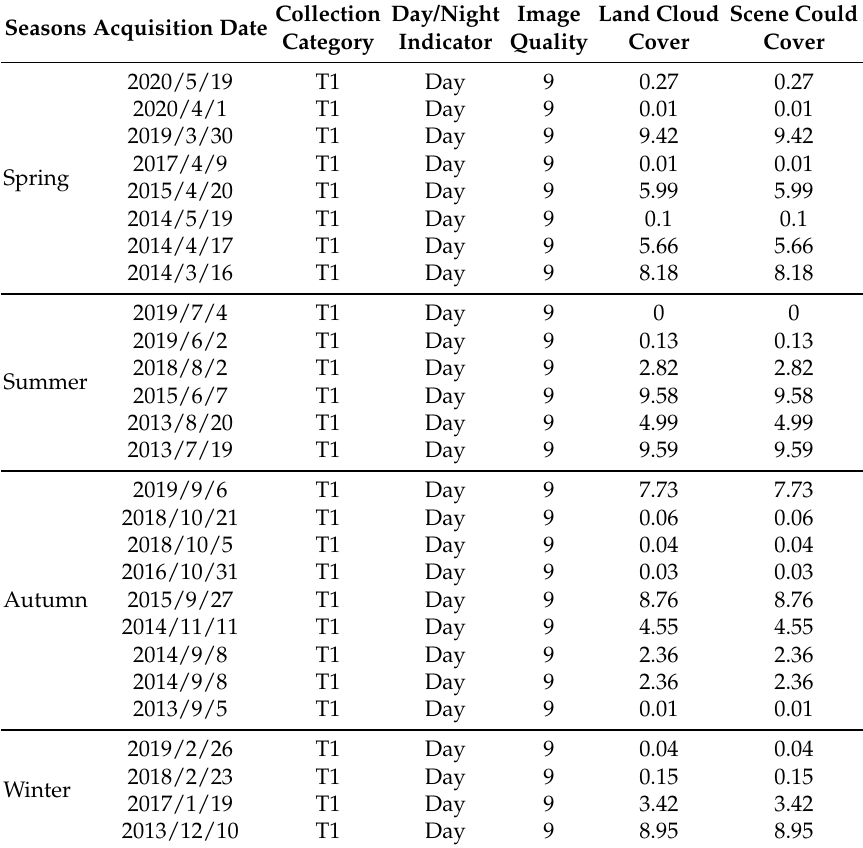
Table A2. The characteristics of Landsat imagery for Paris.